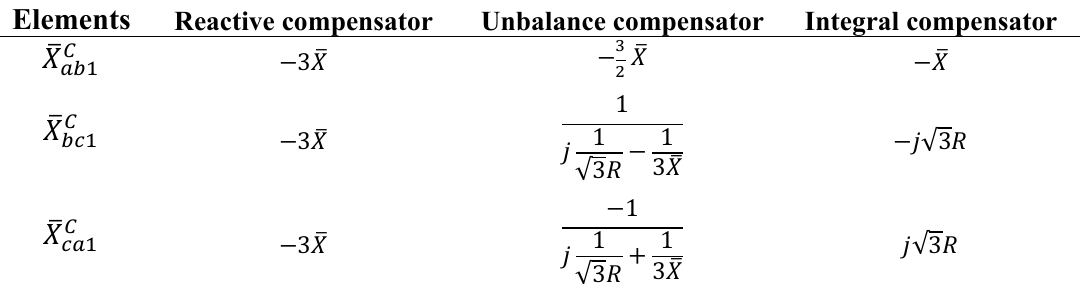
Table 1. Reactive, unbalance (negative-sequence) and integral (reactive + unbalance) compensators for the wye loads.